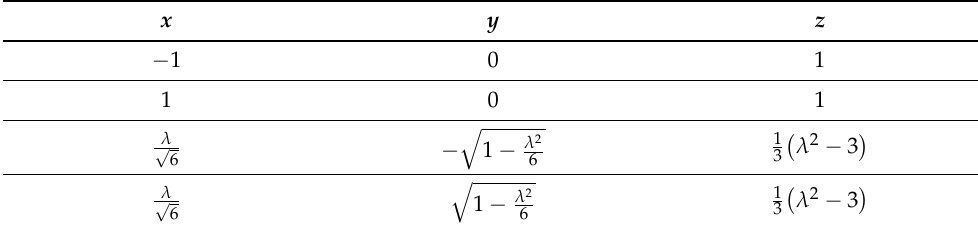
Table 1. Critical points of the planar system defined by (85) and